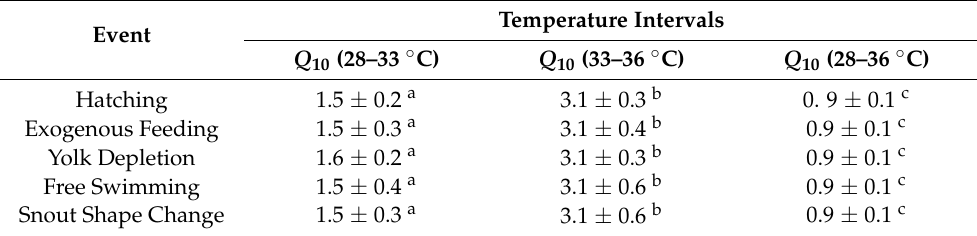
Table 2. Temperature sensitivity in key developmental events in the tropical gar in the tempera- ture experiment. Mean ± SD are presented. Differences between temperature intervals for each developmental event are indicated with different lowercase letters. n = 30 fish per